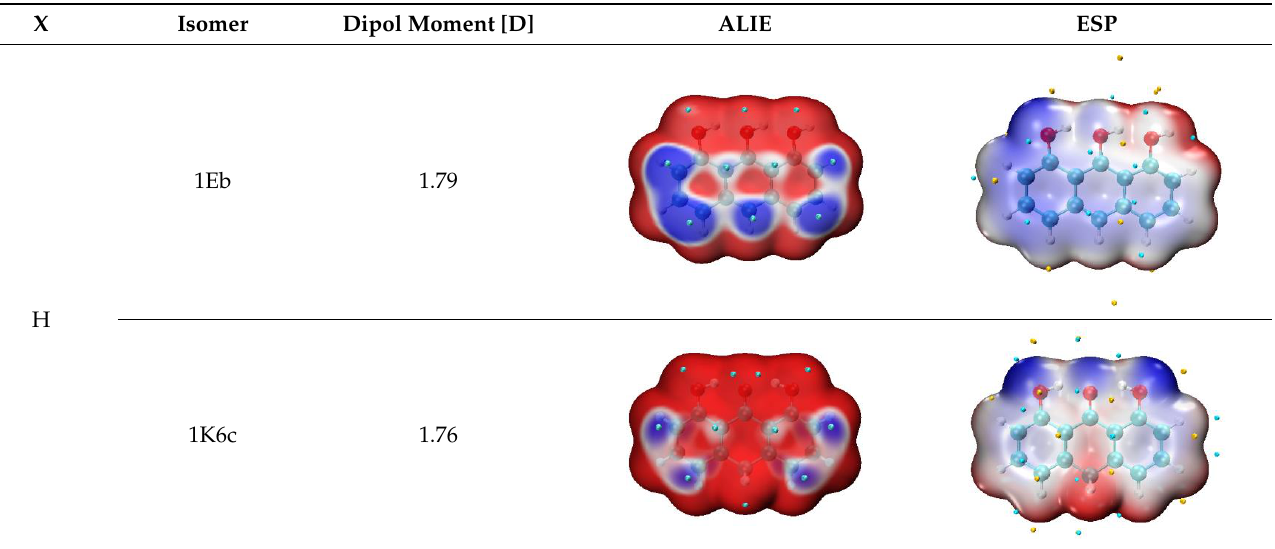
Table 4. Dipol Moment, Average Local Ionization Energy, Electrostatic Potential of enol and ketone form with two hydrogen bonds.